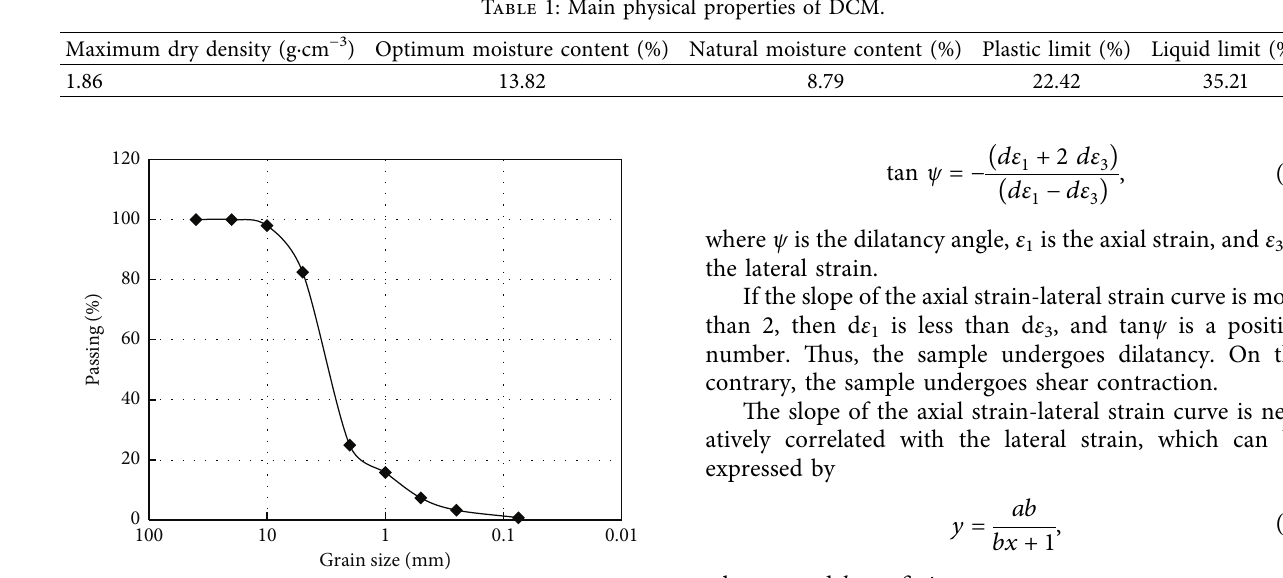
Figure 1: Grain size distribution of the DCM.